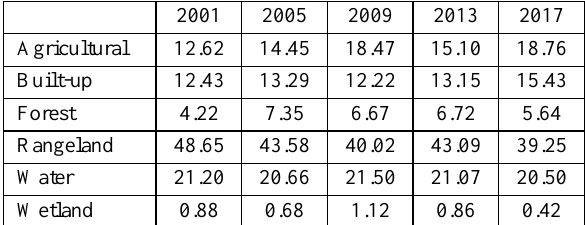
Table 3. Percent area coverage per land cover class